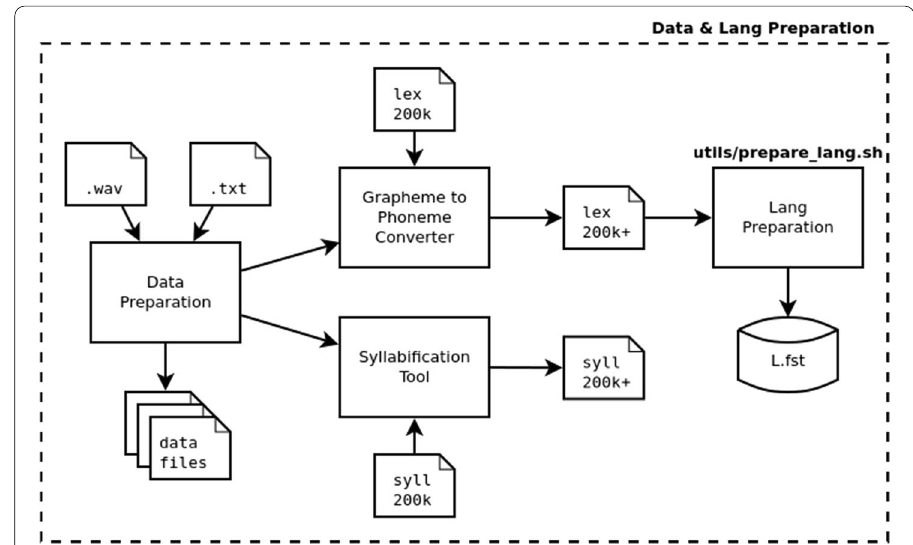
Fig. 6 Data and language (lang) preparation as a pre-processing step for performing forced alignment with Kaldi. Eventual words that are missing in the vocabulary of the phonetic and syllabic dictionaries ( lex 200k and syll 200k , respectively) are inserted during run time thanks to the embedding of FalaBrasil’s G2P and syllabification tools within UFPAlign. Kaldi specific data and language files are also